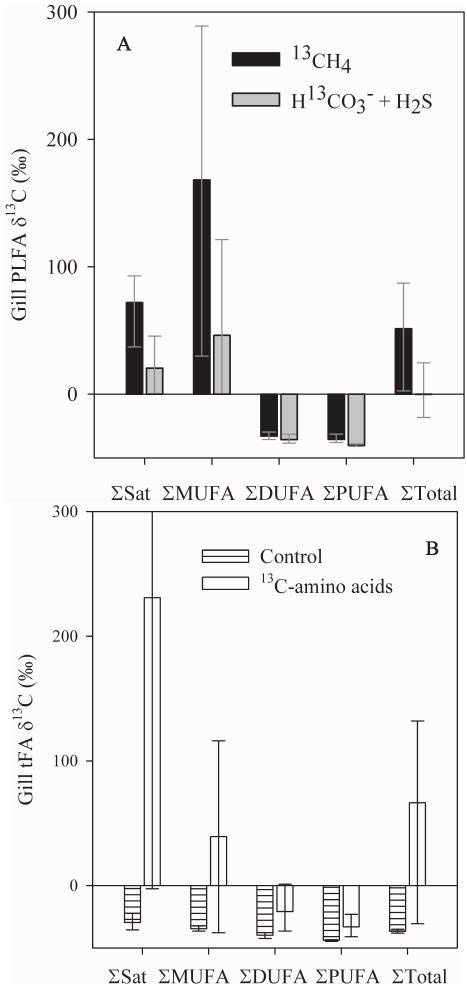
Fig. 1. Bathymodiolus azoricus ( n = 3 specimens, mean ± min- max) gill FAME carbon isotopic signatures. The δ 13 C signa- tures were corrected for the methyle group added during the trans- esterification using formula (1), and weighed averages were ob- tained using formula (2) (A) Gill PLFA after 15 days with 28µM 25% 13 CH 4 (black bars) or 20 days with 6µM H 2 S + 16% H 13 CO − (grey bars). (B) Gill total fatty acids (tFA) after 20 days 3 in control conditions (striped bars) or 20 days with 300µM dis- solved 98% 13 C-amino acids (white bars). Sat: saturated, MUFA: mono-unsaturated, DUFA: di-unsaturated, PUFA: poly-unsaturated